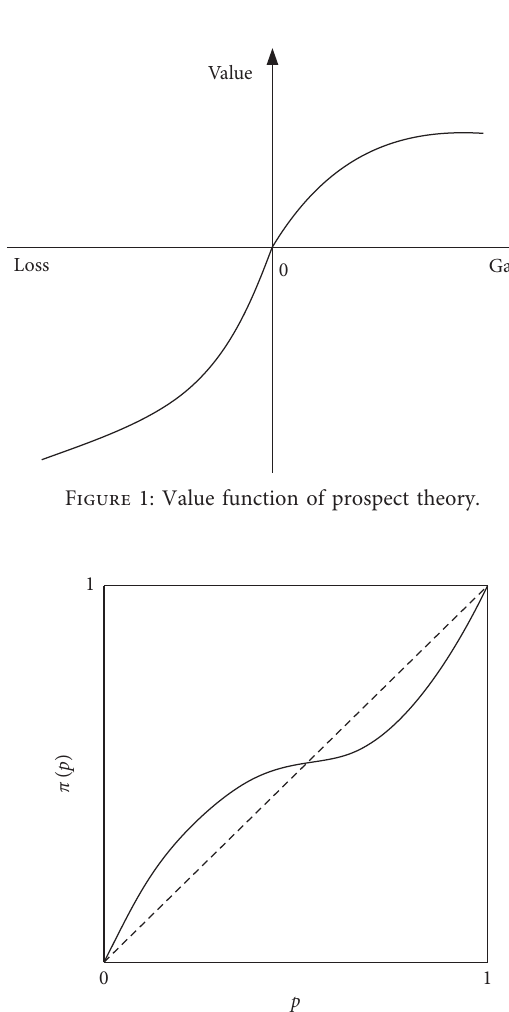
Figure 2: Decision-weighting function of prospect